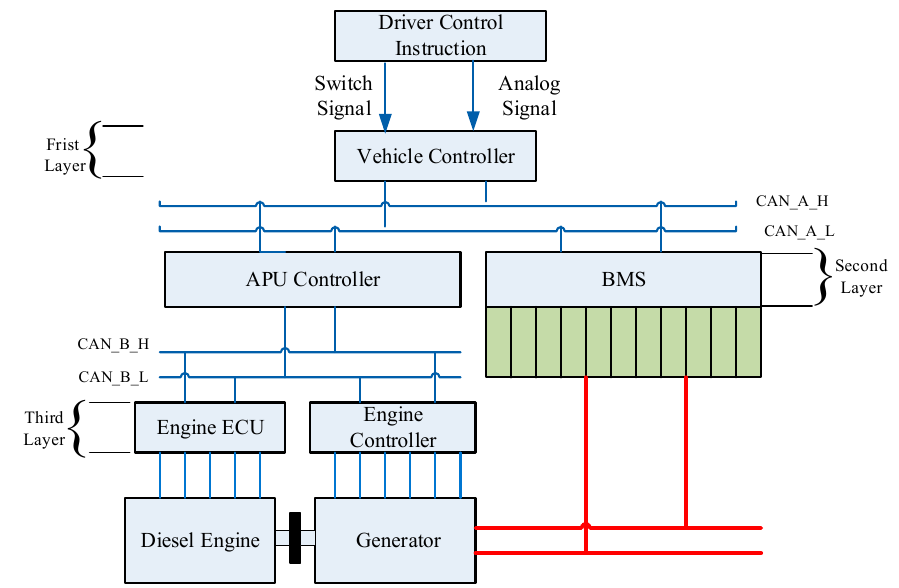
Figure 9. Schematic diagram of hierarchical control.